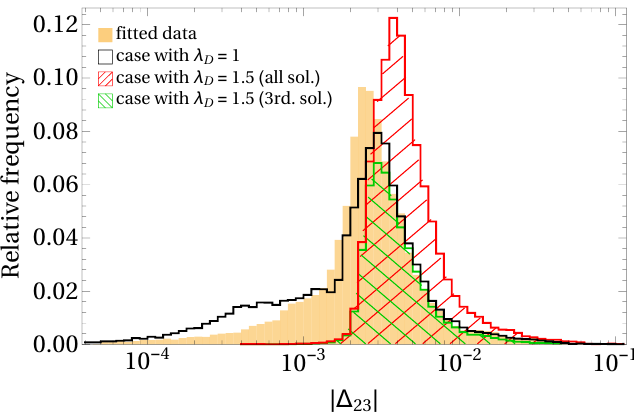
Figure 9 . (Color online) Comparison of the Yukawa coupling (cid:1) 23 obtained with di(cid:11)erent methods. The relative frequency of the value of j (cid:1) 23 j is obtained by counting how often the value appears in the selected bin, divided by the total number of points. We assume the normal hierarchy and take M R (cid:24) m 4 = 10 10 GeV (cid:12)xed. The yellow area represents data points obtained with the minimization algorithm, while the black and red histograms represent the distributions of j (cid:1) 23 j calculated with our analytical procedure, described in section 3. The black histogram uses (cid:21) D = 1 and the red histogram (cid:21) D = 1 : 5. The green histogram shows a part of the red histogram that is determined by taking only the third solution of the fourth order equation